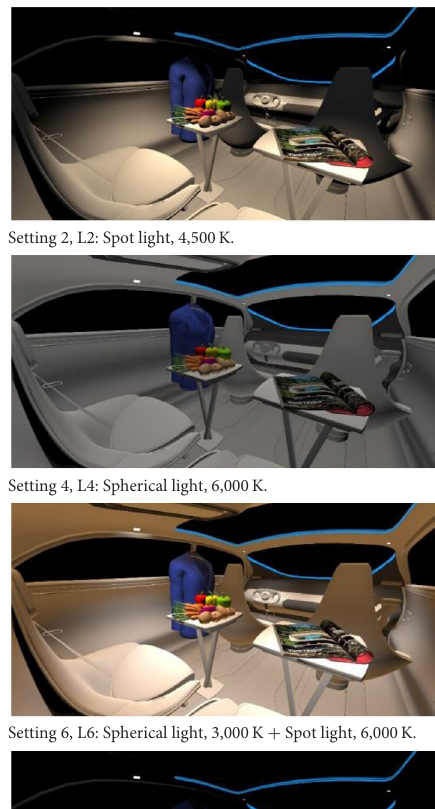
TABLE 2 VR-prerendered images for arbitrary paired comparisons with illumination